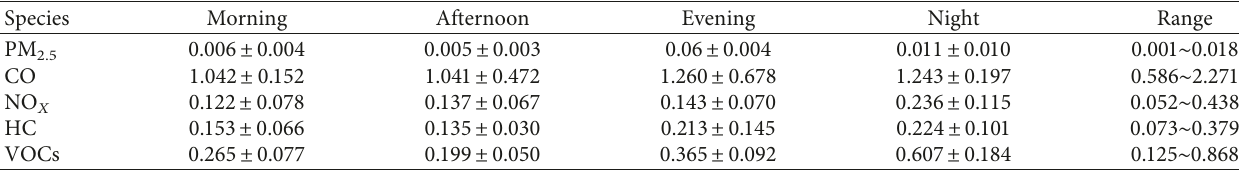
Figure 4: Weekday-weekend pattern of pollutant emissions. The comparison of weekday and weekend traffic volume (a), PM NO X (d), HC (e), and VOCs (f) during the four sampling periods. Table 3: Average EFs (g · veh − 1 · km − 1 ) during different sampling